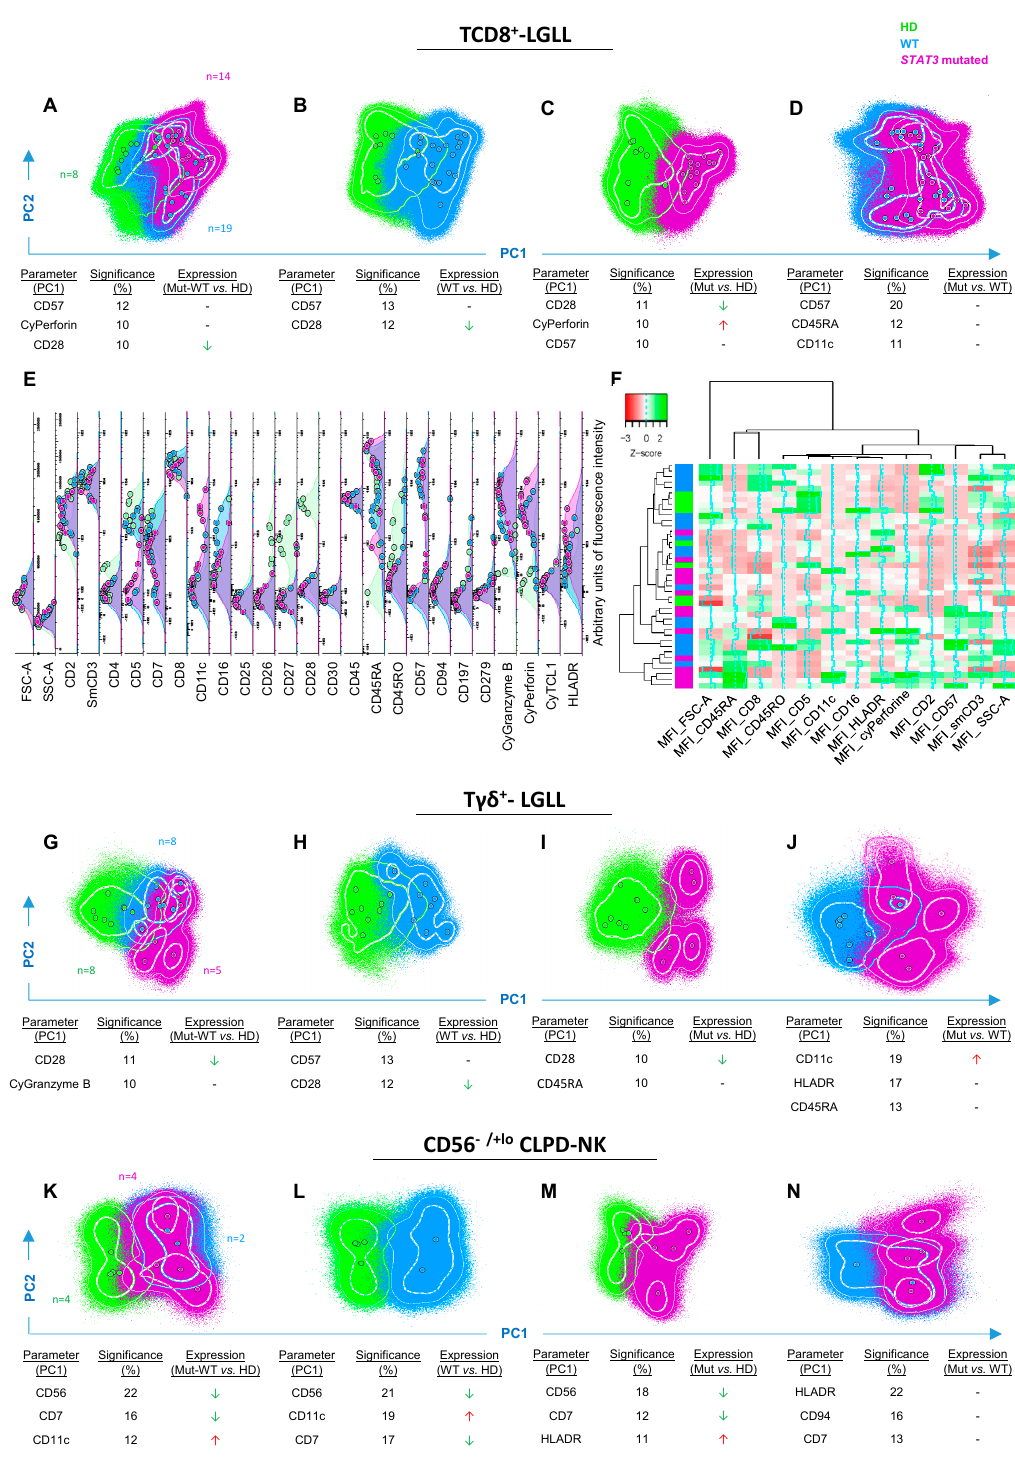
Figure 1. Phenotypic profiles of STAT3 -mutated vs. WT clonal TCD8 + -LGLL, T γδ + -LGLL, and CD56 − /+ lo CLPD-NK cell populations compared to their normal cell counterpart. Multidimensional phenotypic comparisons—principal component (PC) 1 vs. PC2, automatic population separator 1 (APS1) representations—showing those markers providing the best resolution (i.e., separation) between STAT3 -mutated (depicted in purple) and WT (highlighted in blue) clonal LGL populations vs. normal cell populations (depicted in green). Overexpression (red arrows), underexpression (green arrows), or heterogeneous trend of expression (hyphen) of markers between the di ff erent set of cell populations. In all PC1 vs. PC2 (APS1) plots, solid circles represent median values for all phenotypic parameters evaluated, inner (dotted) and outer (solid) lines represent the